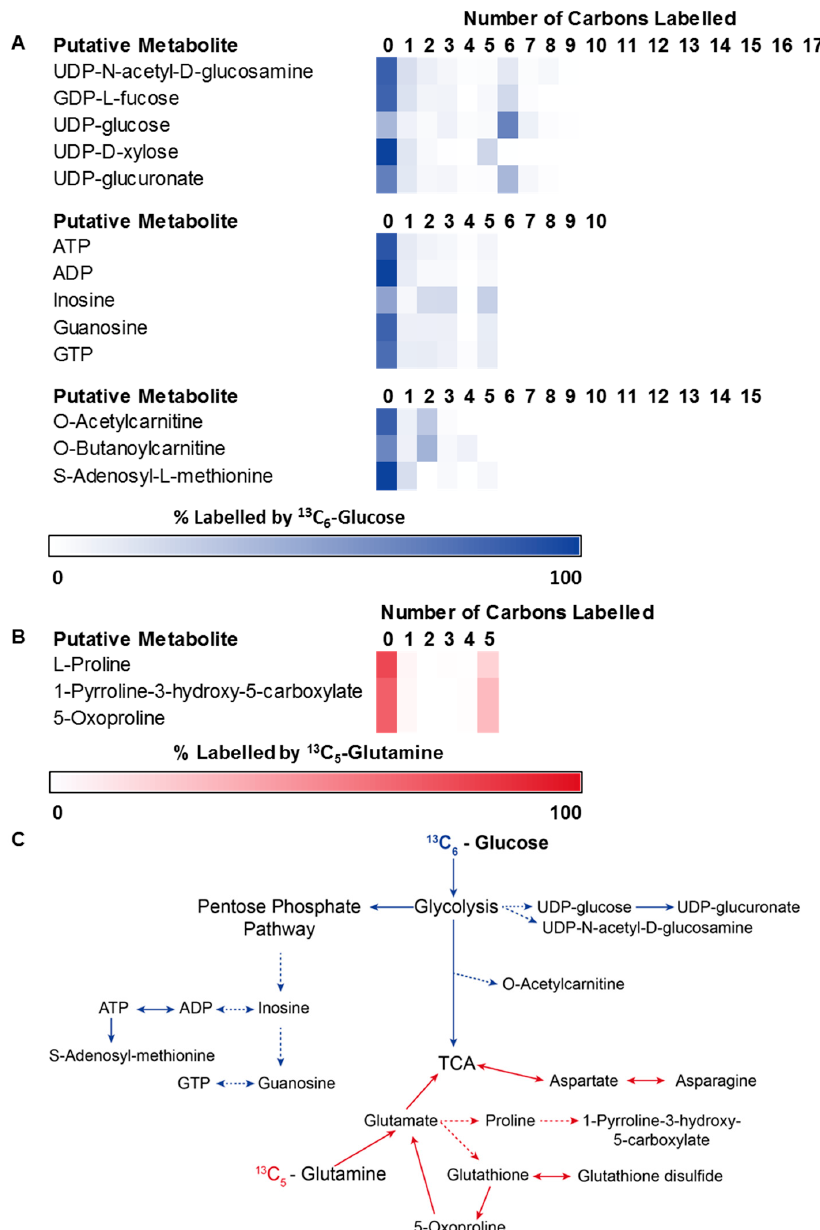
Figure 6. Metabolome-wide detection of isotope-labelled metabolites arising from glucose and glutamine. Heat-map shows the percentage 13 C-enrichment of each isotopologue for metabolites with >10% 13 C isotope enrichment. ( A ) Metabolites labelled from U- 13 C-glucose are associated with sugar-nucleotides, nucleotide metabolism and amino acid metabolism. Scale: white represents 0% labelling and blue represents 100% labelling; ( B ) Additional metabolites labelled from U- 13 C-glutamine were limited to amino acid metabolism. Scale: white represents 0% labelling and red represents 100% labelling. ( C ) Schematic representing the pathways involving labelled metabolites from U- 13 C-glucose and U- 13 C-glutamine. (UDP: uridine diphosphate, GDP: guanosine diphosphate, ATP: adenosine triphosphate, ADP: adenosine diphosphate, GTP: guanosine triphosphate).